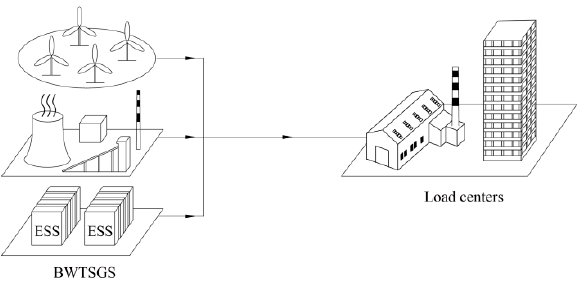
Figure 1. Configuration of a bundled wind-thermal-storage generation system (BWTSGS).